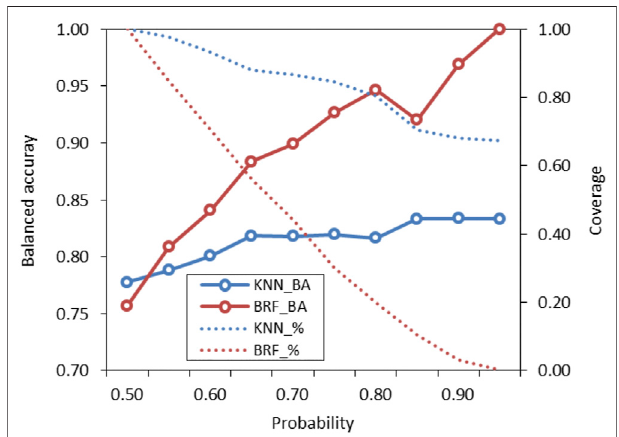
FIGURE5| VariationofperformanceoftheKNNandtheBRFmodelson the ES based on probability threshold for prediction domain de fi nition. Solid lines refer to the overall BA while dotted lines refer to the percentage of compounds included in the domain of the model (coverage) on the total included in the